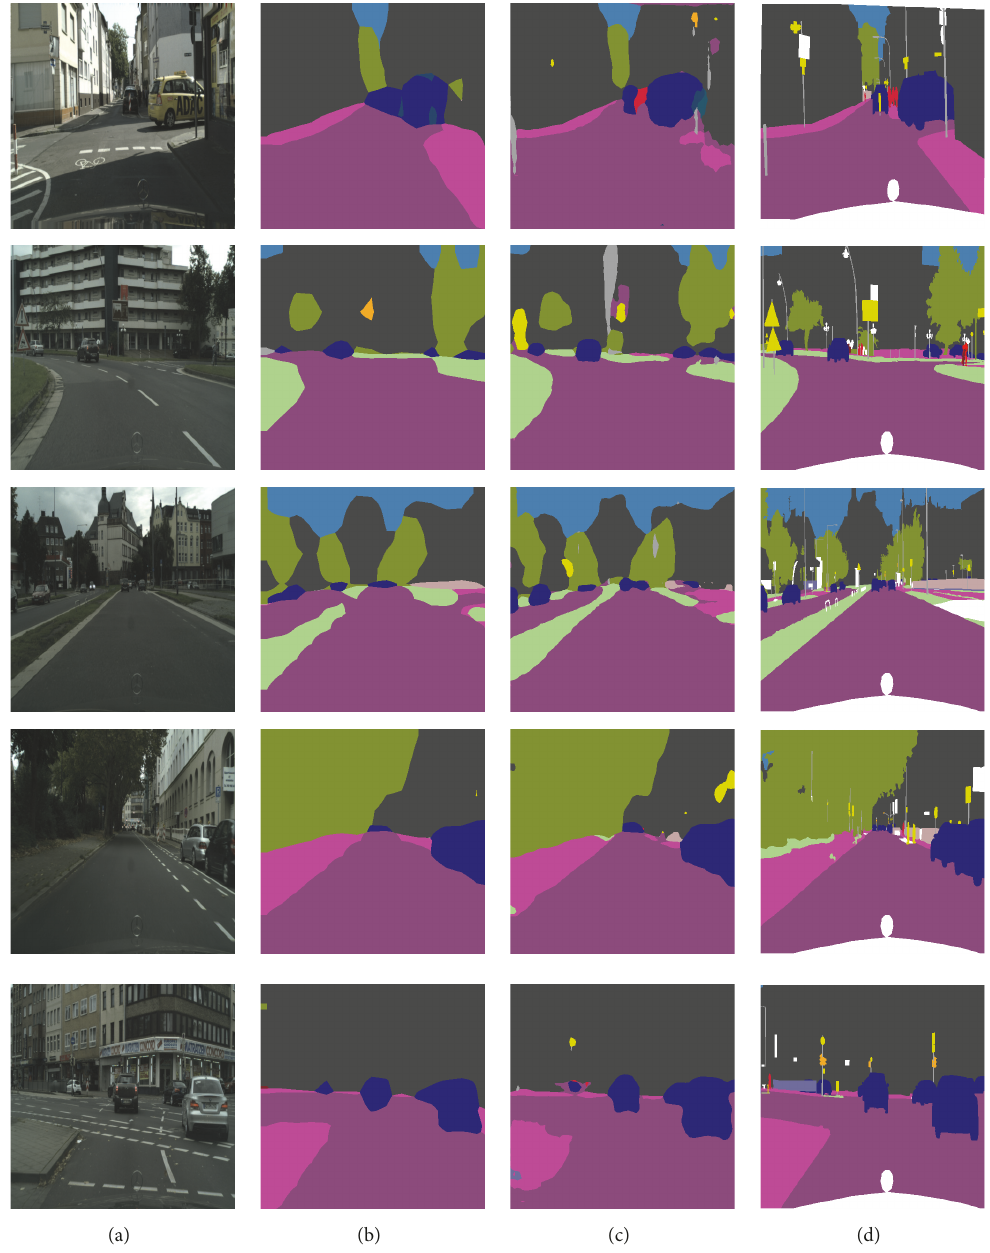
Figure 6: Comparison of different semantic segmentation algorithms on Cityscapes: (a) original image; (b) FCN-8S; (c) our method; (d) ground